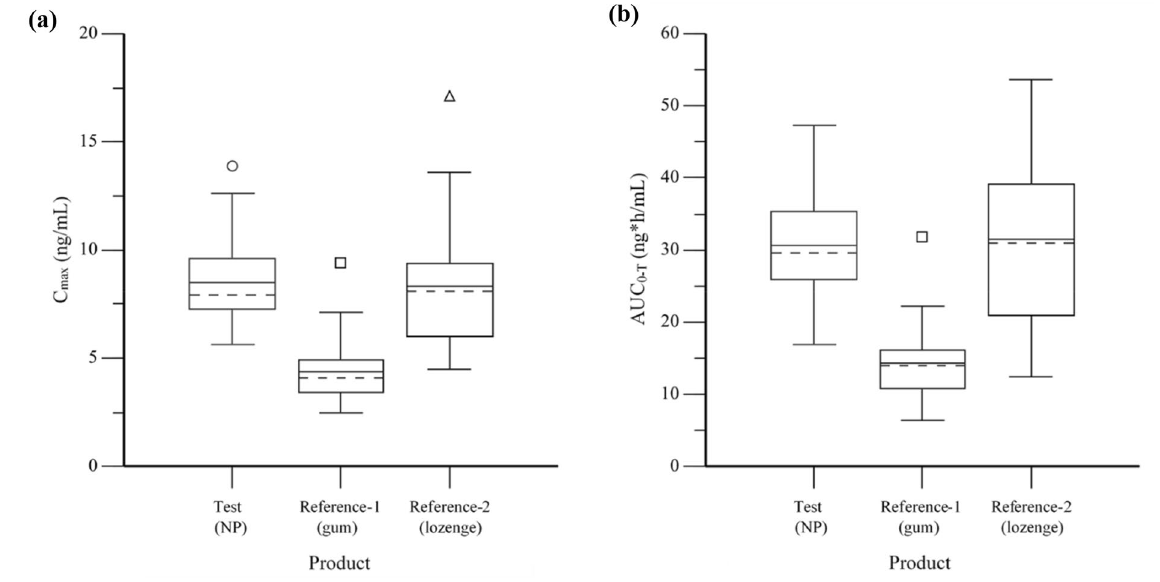
Figure 3. Box-and-whiskers plot of plasma nicotine C max ( a ) and AUC 0-T ( b ) among adult smokers after single oral product use of three nicotine products under fasting condition. Arithmetic mean values are shown as solid lines and median values as dashed